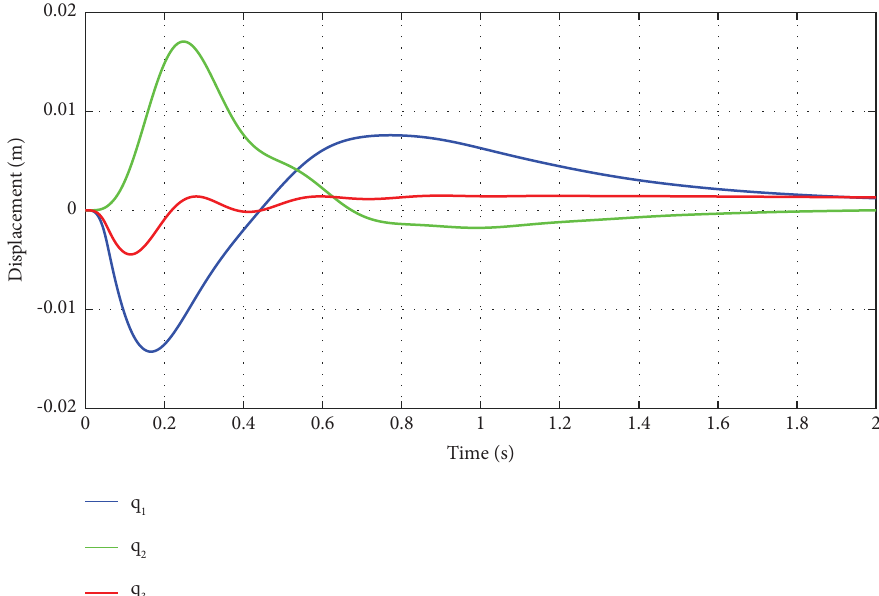
Figure 2: Displacements of parts of the mobile antiaircraft weapon system after launch at the angle of attack α placement of unsprung mass m 1 of the front suspension, q 2 -vertical displacement of unsprung mass m 2 of the rear suspension, and q 3 - vertical displacement of mass center of the vehicle body.